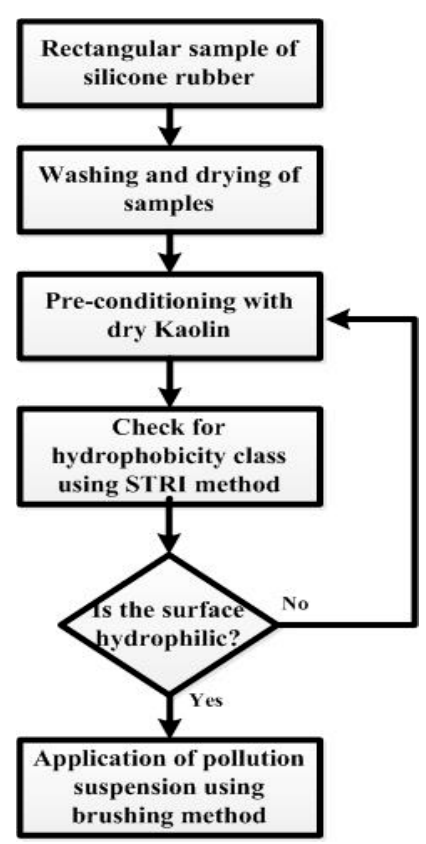
Figure 1. Flowchart of pollution application.